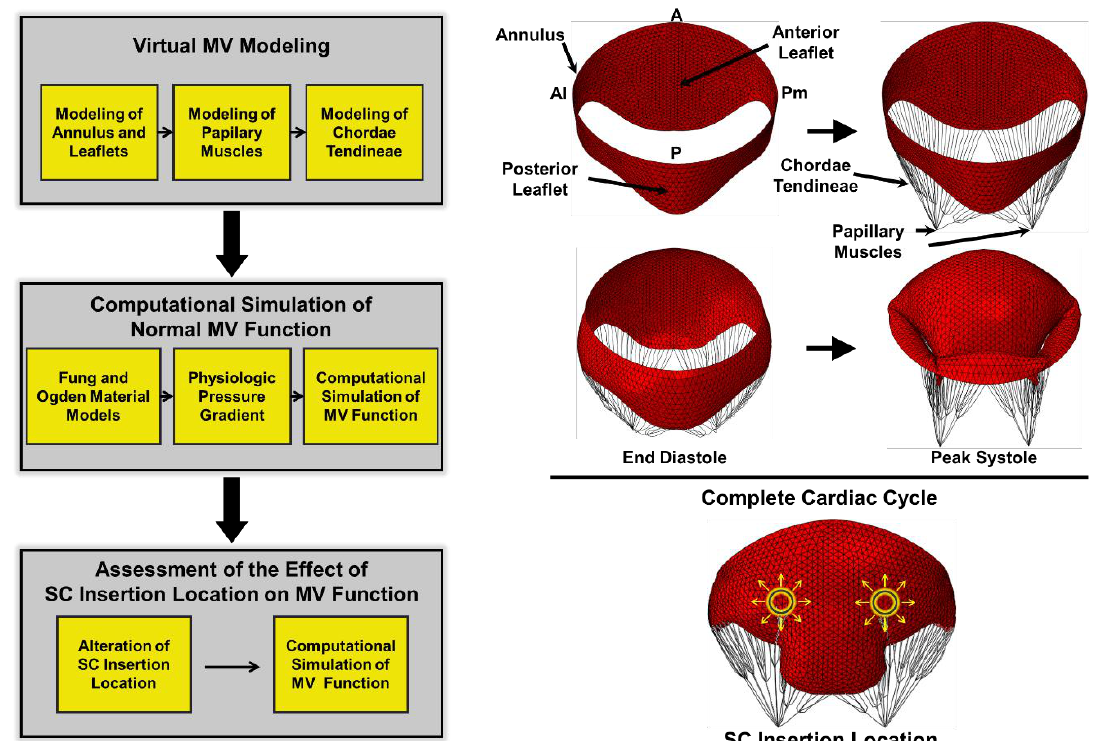
Figure 1. Study protocol for virtual parametric MV modeling and computational simulation of MV function to determine the effect of altering the SC insertion location. A — anterior; Al — anterolateral; P — posterior; Pm — posteromedial.